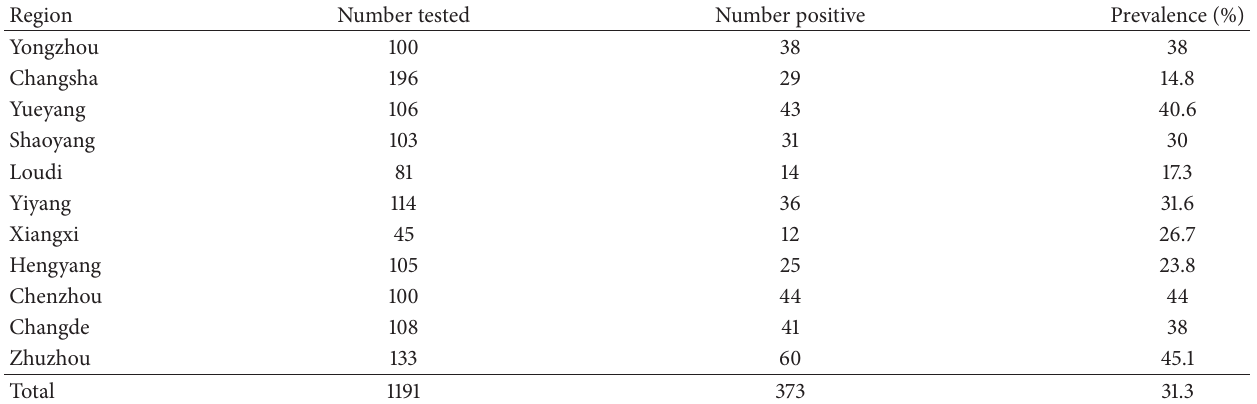
Table 1: Seroprevalence of Toxoplasma gondii infection in sows in Hunan Province, China.